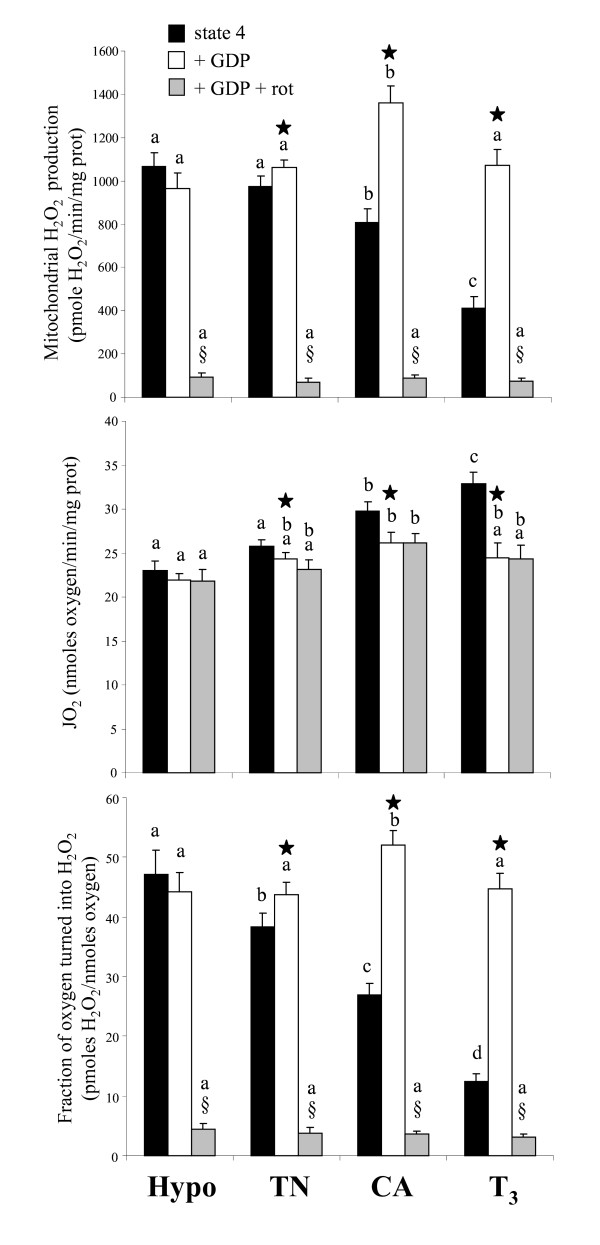
Release of H2O2 by intermyofibrillar mitochondria isolated from red gastrocnemius muscle of thermoneutral controls (TN), cold-acclimated (CA), hypothyroid (hypo) or T3-treated (T3) ducklings. Oxygen consumption (JO2) was measured in parallel, and H2O2 production was expressed per oxygen consumed. Measurements were performed in the presence of 0.3% FAF-BSA and 5 mM succinate without (black columns) or with 1.5 mM GDP (open columns) or with 1.5 mM GDP + 5 μM rotenone (grey columns). Within an experimental condition of respiration (succinate, succinate + GDP or succinate + GDP + rotenone), bars with different letters are significantly different (P < 0.05). * indicates a significant effect of GDP (P < 0.05); § indicates a significant effect of rotenone (P < 0.05).